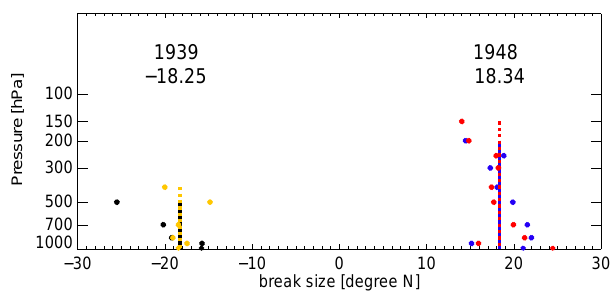
Figure 7. Vertical profiles of wind direction break size estimates Figure 7: Vertical profiles of wind direction break size estimates at Bismarck (WMO ID at Bismarck (WMO ID 72764) for breaks in 1939 and 1948. The 72764) for breaks in 1939 and 1948. The bullets are the estimated differences detected at each pressure level (black and blue at 00 GMT, yellow and red at 12 GMT). The solid and bullets are the estimated differences detected at each pressure level dotted lines are the respective vertically constant adjustment valuesmean values for the (black and blue at 00:00UTC, yellow and red at 12:00UTC). The whole vertical profiles solid and dotted lines are the respective vertically constant adjust- ment mean values for the whole vertical